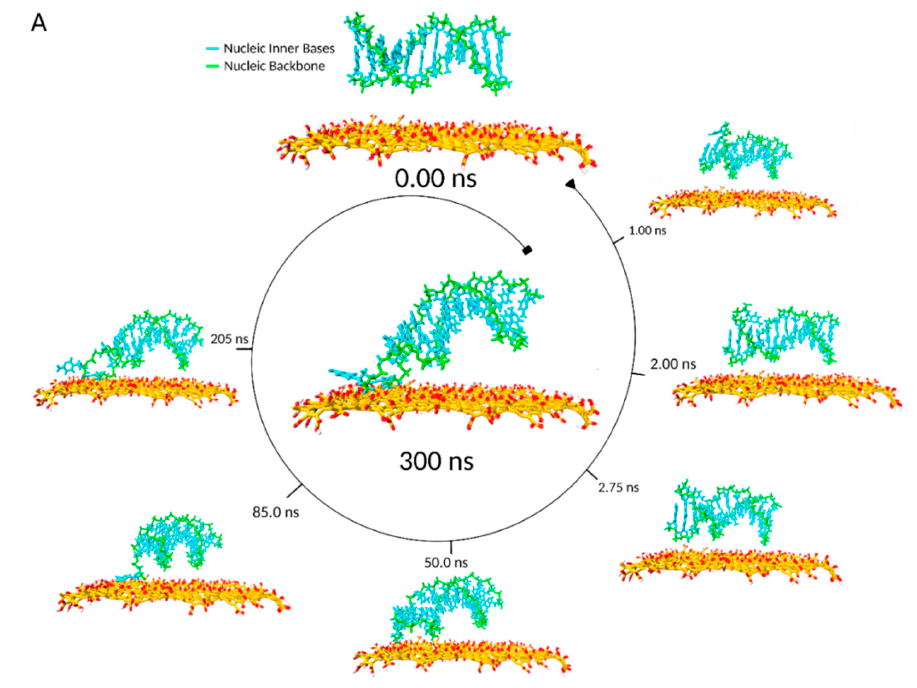
Figure 7. Trajectory snapshots ranging from 0 to 300 ns of dsDNA and GO in the presence of both Mg 2+ and Cl − atoms (ions not shown).